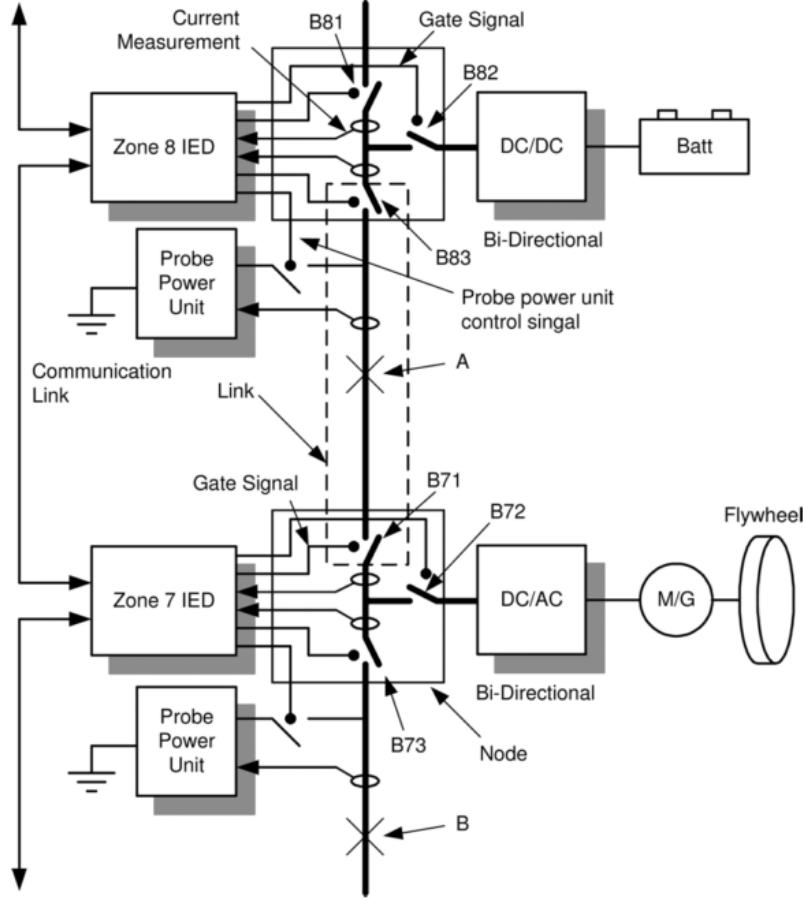
Figure 17. Differential Protection Scheme Schematic Diagram [25].